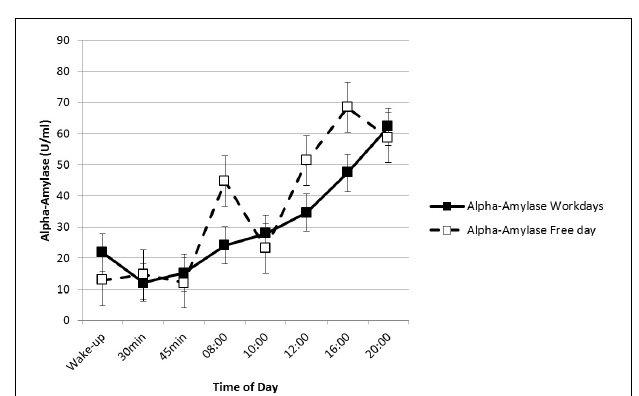
FIGURE 3 | The diurnal course of alpha-amylase